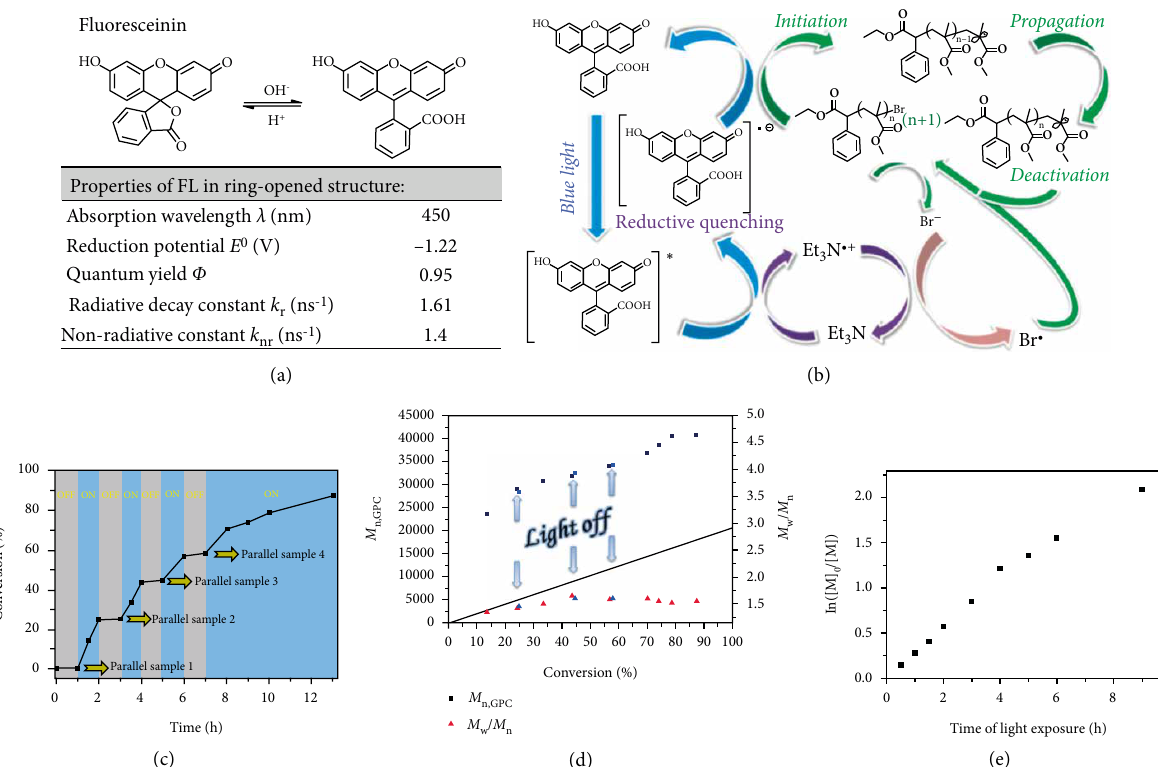
Figure 9: (a) pH-dependent equilibrium between the spirolactone form and the ring-opened form of fluorescein (FL) and optical properties of fluorescein in ring-opened structure. (b) Proposed mechanism of metal-free PET–ATRP photo-mediated with fluorescein as an organic photocatalyst. (c) Plot of monomer conversion versus time demonstrating the effect of blue light on the control over polymerization propagation through repeated “on-off” cycling of irradiation (blue regions) and light source removal (shaded regions); ) and molecular weight distribution ( 𝑀 w /𝑀 number-average molecular weight ( 𝑀 𝑛,𝐺𝑃𝐶 function of exposure time (e) for metal-free PET–ATRP of MMA in the “on/off” light irradiation experiment. Polymerization conditions: MMA TEA FL EBPA = 200 : 1 : 0.15 : 4.5 , VMMA = 1.0 mL, VDMSO = 2.0 mL; samples were irradiated by a blue LED : [ : [ : [ [ ] ] ] ] 0 0 0 0 at rt. (Adapted with permission from Ref.